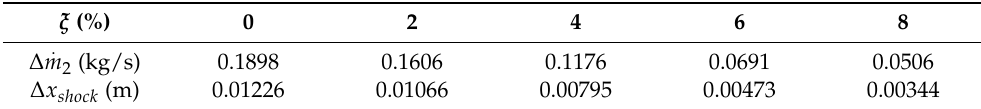
Table 3. Parameters amplitude variation under different ξ .